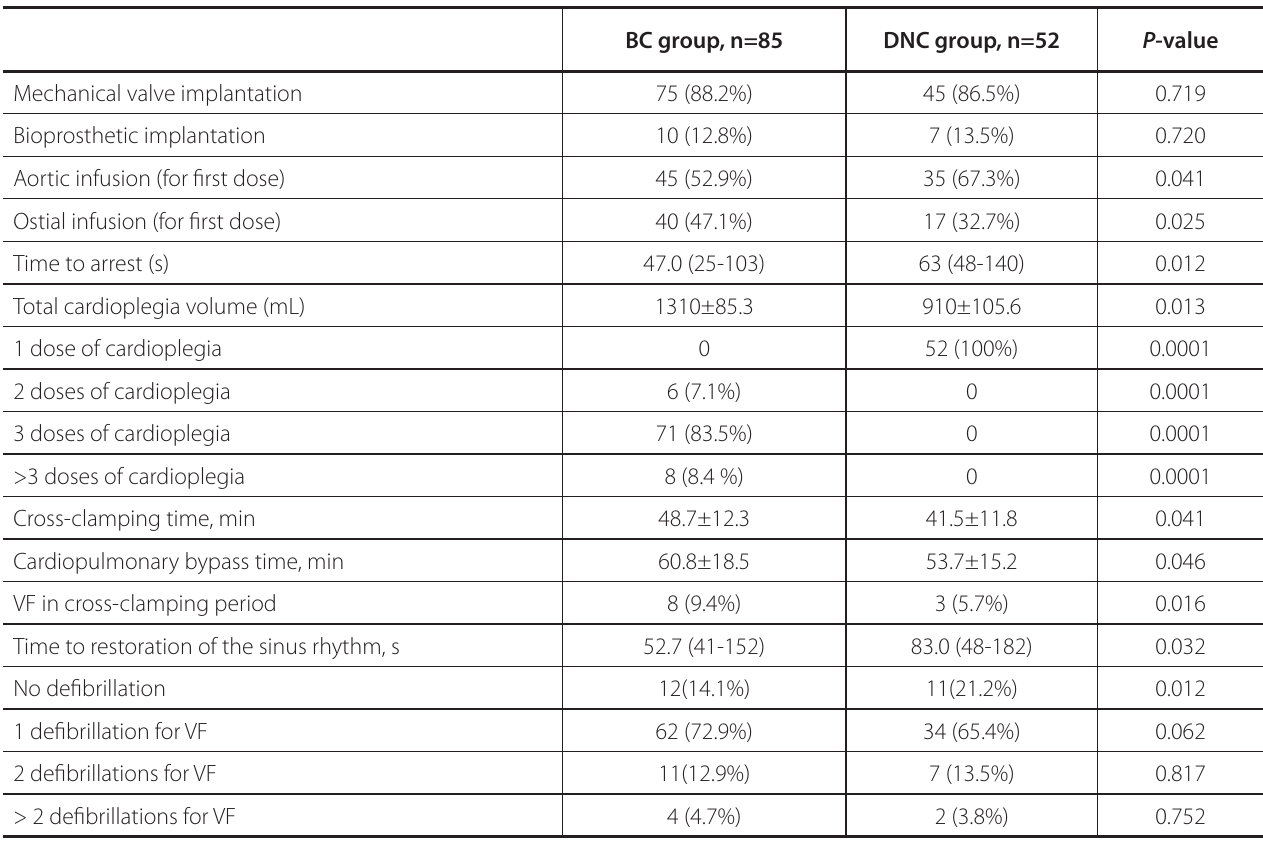
Table 2 . Intraoperative